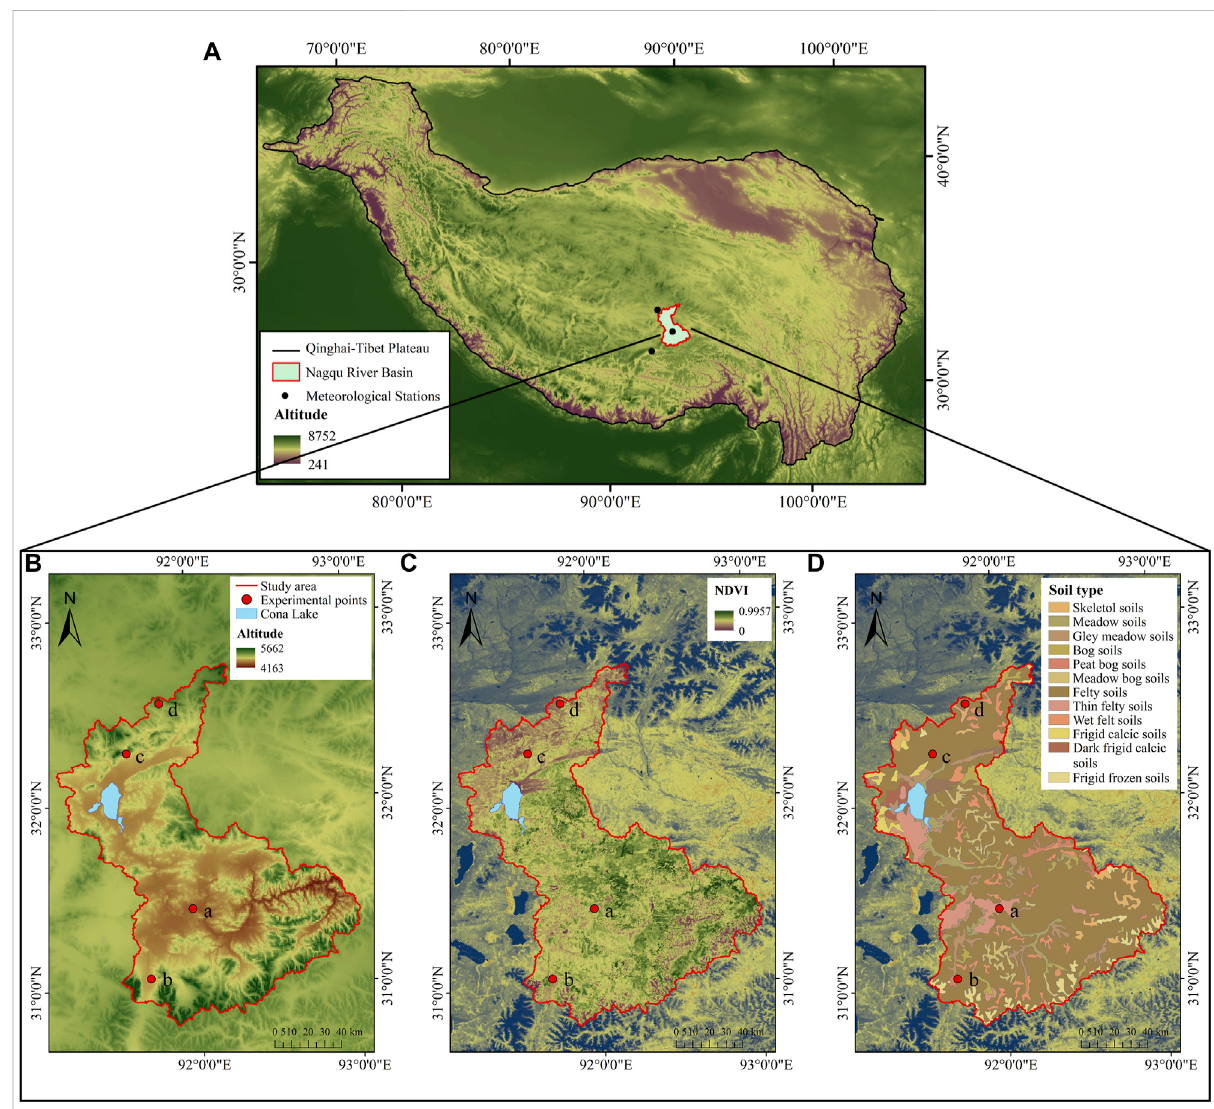
FIGURE 2 Map of the study area. Contains elevation characteristics of the Qinghai-Tibet Plateau (A) , elevation characteristics of the study area and location of the prototype experimental site (B) , NDVI distribution (C) , and soil type distribution (D)